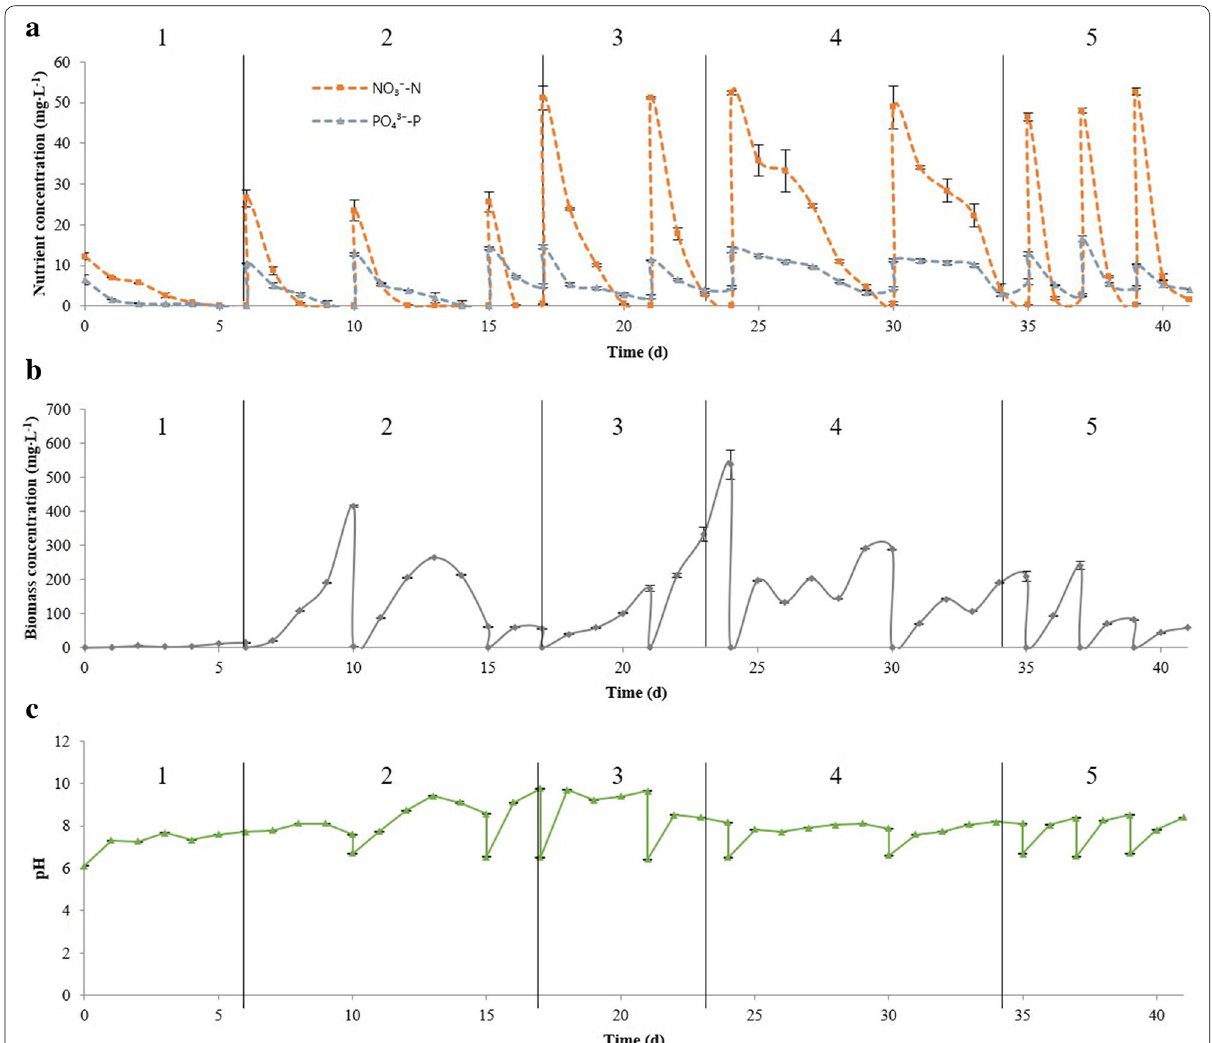
Fig. 4 S. vacuolatus ACUF_053 a nitrogen (NO 3 − -N) and phosphorus (PO 43 − -P) removal kinetics in the PBR under semi-batch conditions; b pH changes in the medium of the biofilm photobioreactor and, c microalgal biomass growth in the medium of the biofilm PBR. The numbers